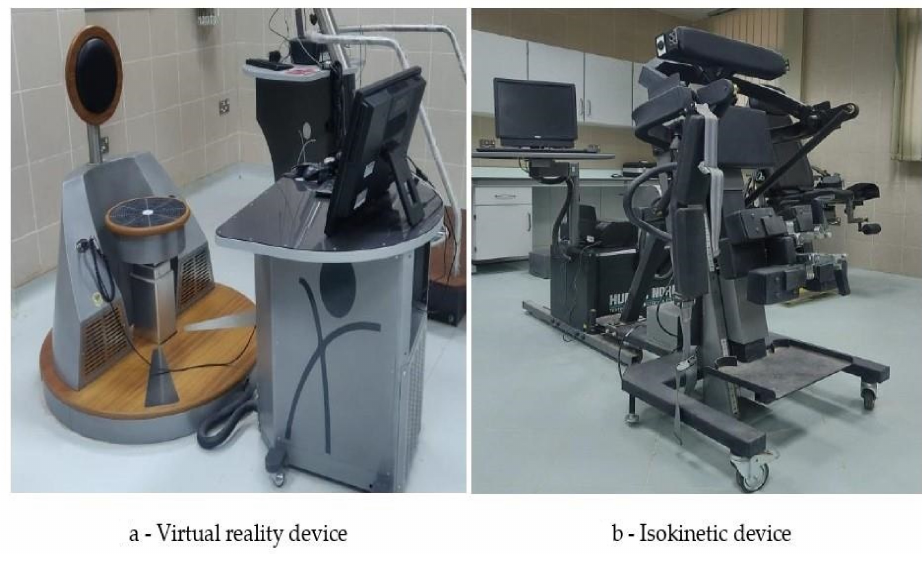
Figure 2. The virtual reality and isokinetic